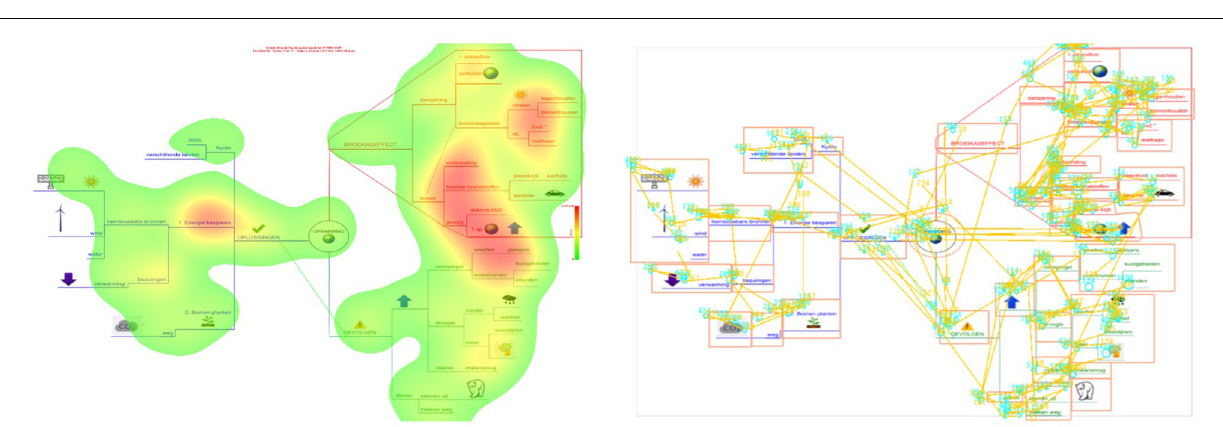
FIGURE 1 | Difference between a mind map (Left) and a concept map (Right) .